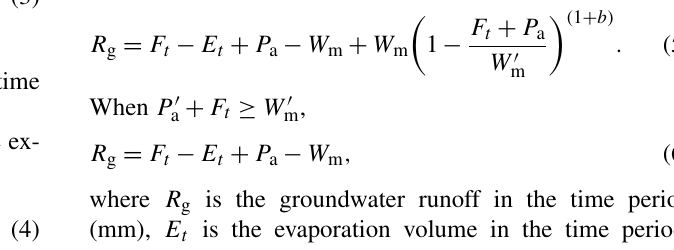
where f is infiltration rate (mm h − 1 ), i is rainfall inten- sity (mm h − 1 ), n is an exponent, f c is the stable infiltration rate (mm h − 1 ), m is the surface soil moisture (mm), u is an exponent indicating the decreasing speed of the infiltration rate with the increase in the soil moisture, and f m is the in- filtration capacity inside the grid (mm h − 1